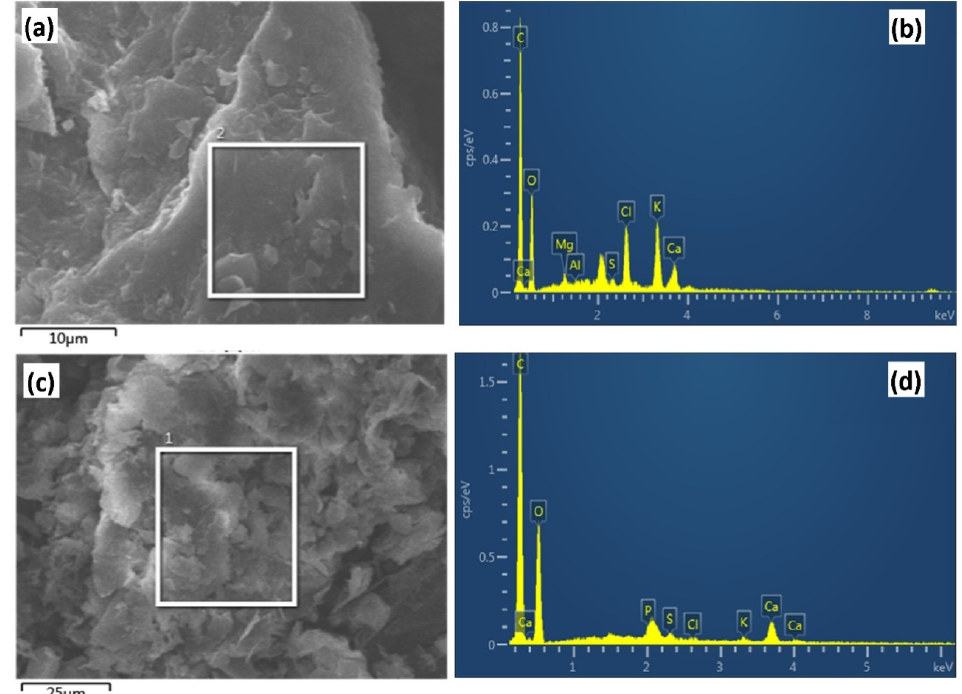
Figure 2. SEM image and EDS mapping results of ( a , b ) the Hydrocotyle biomass, and ( c , d ) PA-pretreated biomass (PA 0.5 Mass).